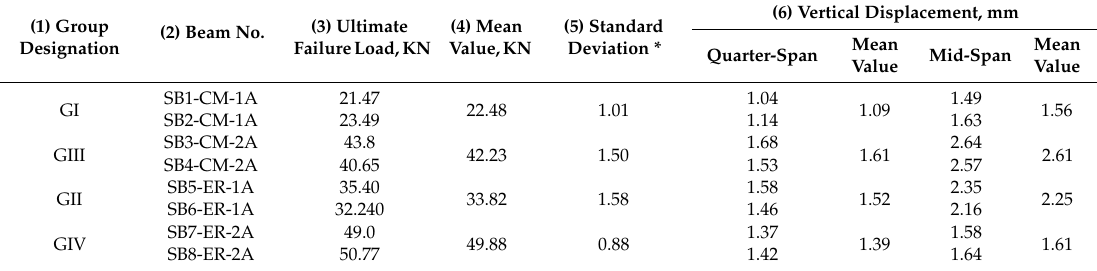
Table 6. Test results of segmental beams.